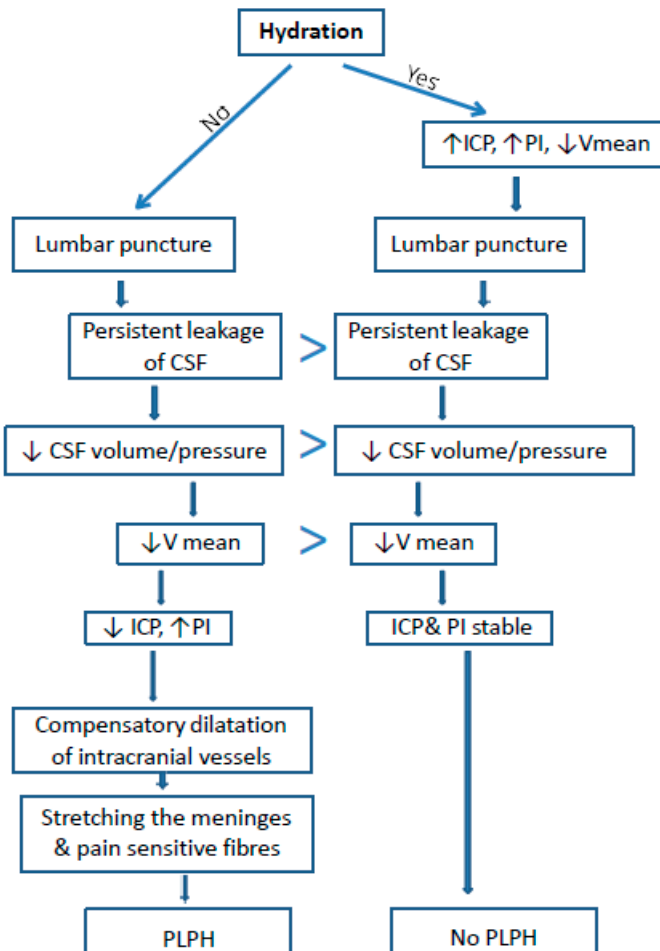
Figure 1. Proposed mechanism of PLPH pathogenesis and the influence of hydration on the incidence of PLPH and cerebral blood flow (based on our study). ICP–intracranial pressure, PI–Gosling’s pulsatility index, V mean–mean velocity, CSF–cerebro-spinal fluid, PLPH–post lumbar puncture